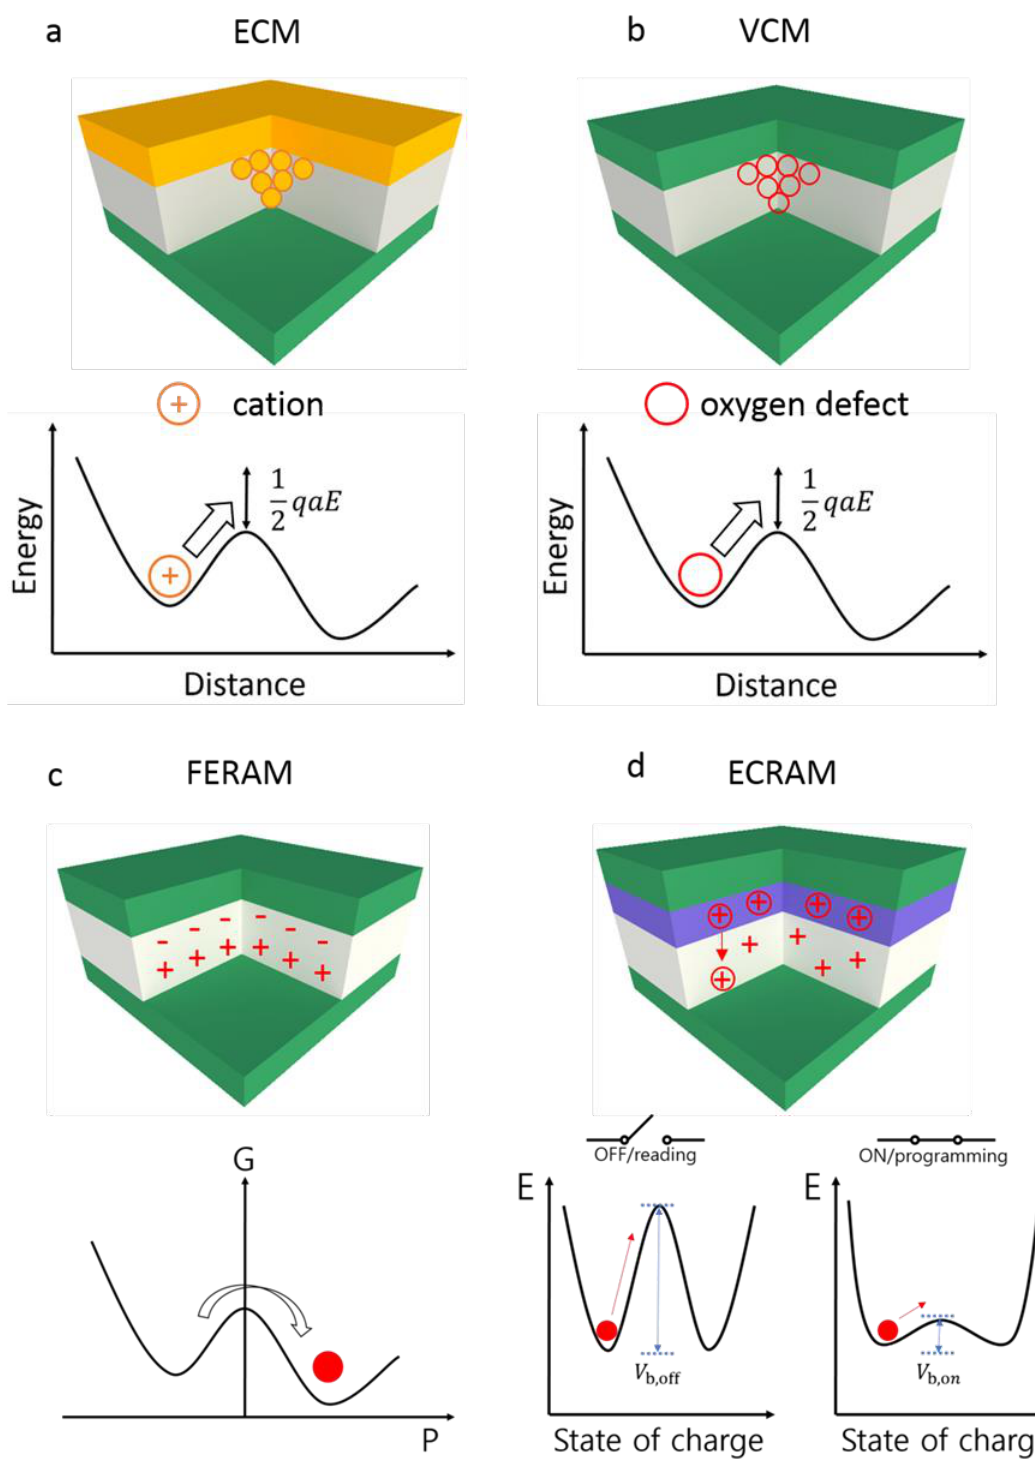
Figure 3. Ion-movement-based resistive switching devices. ( a ) Schematic of structure and of the field-driven acceleration of cation transport for ECM-based resistive switching device. ( b ) Schematic of structure and of the field-driven acceleration of defect transport for VCM-based resistive switching device. ( c ) Schematic of structure and of the field-driven cation movement for FERAM-based resistive switching device. G and P denote Gibbs energy and polarization, respectively. ( d ) Schematic of structure and of operation-specific change in blocking barrier for ECRAM-based resistive switching device. E denotes energy